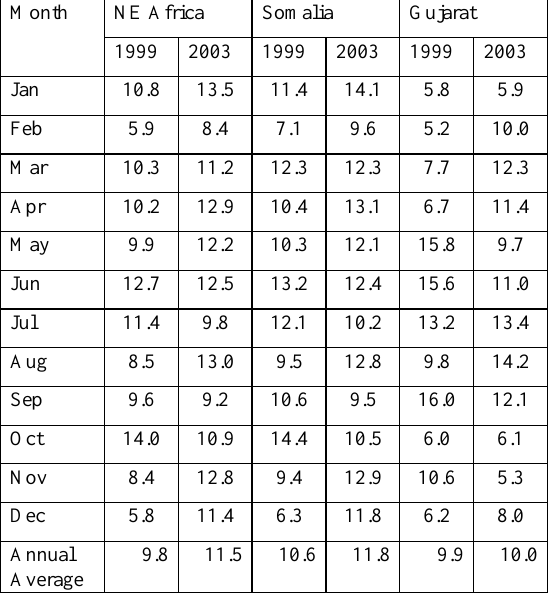
Table 5. Comparison of Daily Maximum IDDI (K). Table-5. Comparison of Daily Maximum IDDI (K) NE Africa Somalia Gujarat Month